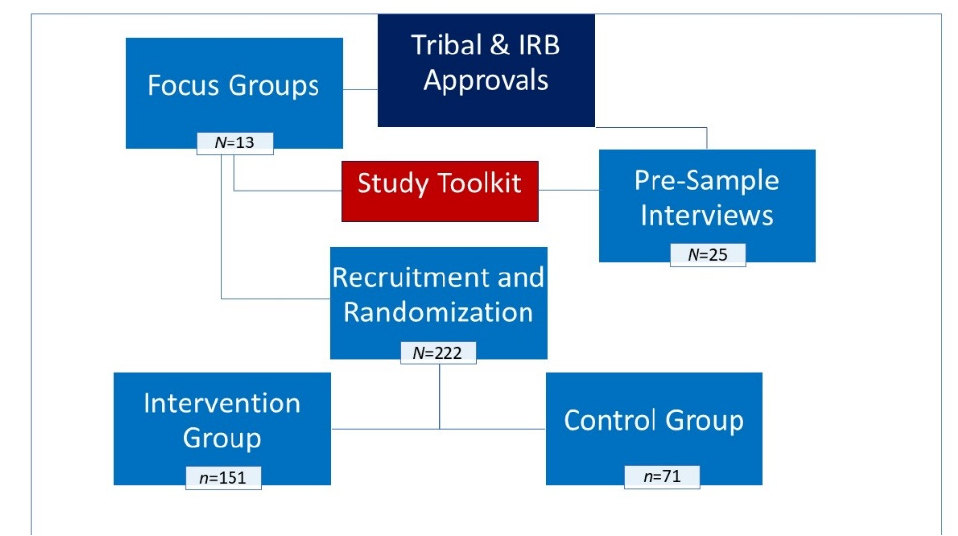
Figure 1. Flow diagram of study design.